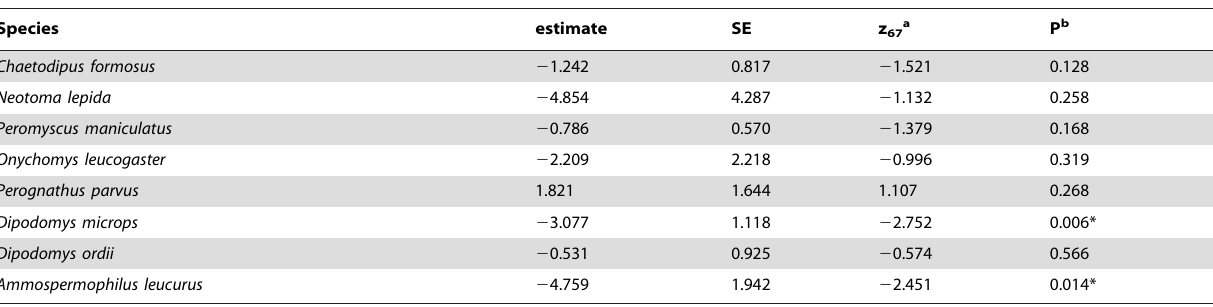
Table 2. Regression